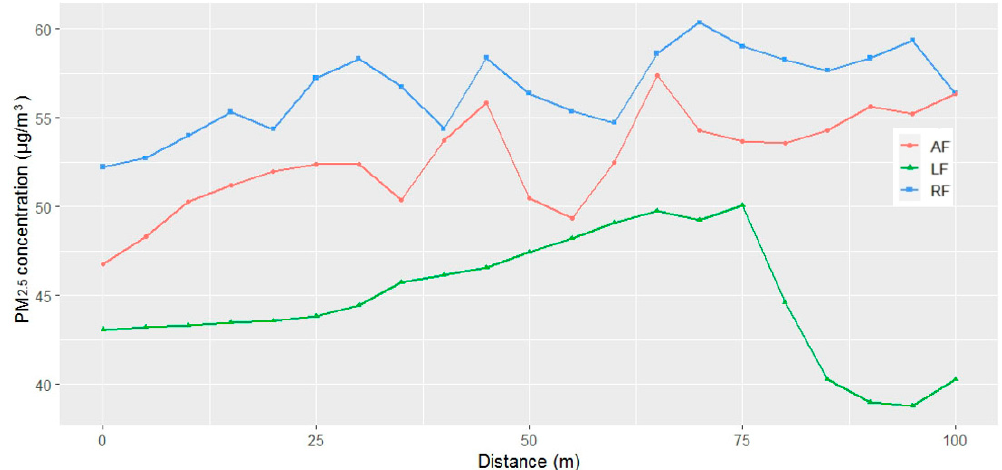
Figure 2. The PM 2.5 reduction distance of RF, LF, and AF. Note: Refer to Table S1 for the meaning of the abbreviated forest types.